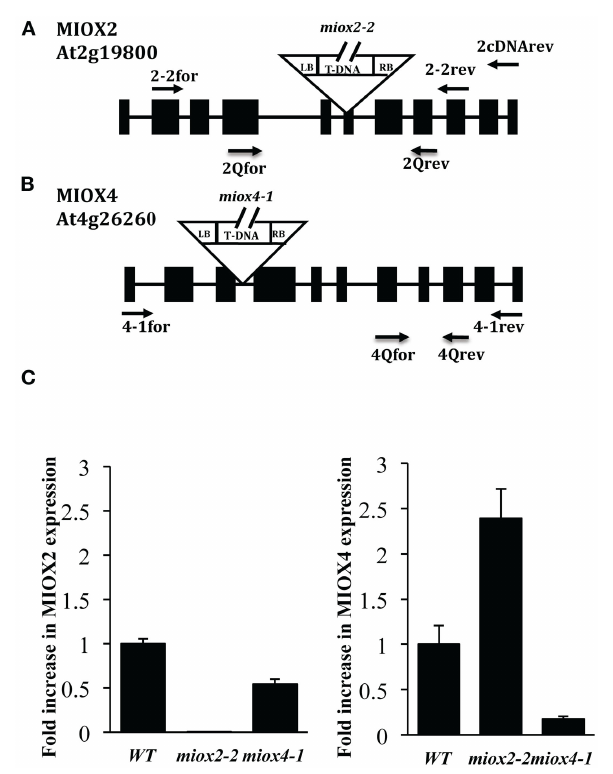
FIGURE 3 | Root growth in different nutrient conditions. WT and mutant seeds were surface-sterilized, placed on agar with different nutrients, stratified for 3days at 4˚C, then placed at room temperature under long-day conditions. Root length was measured every other day. (A) No nutrients. (B) Low nutrients. (C) Optimal nutrients. Bars represent the mean ± SE where n = 3–5, with each replicate containing 10–15 seedlings. *Indicates p -value ≤ 0.05 as compared